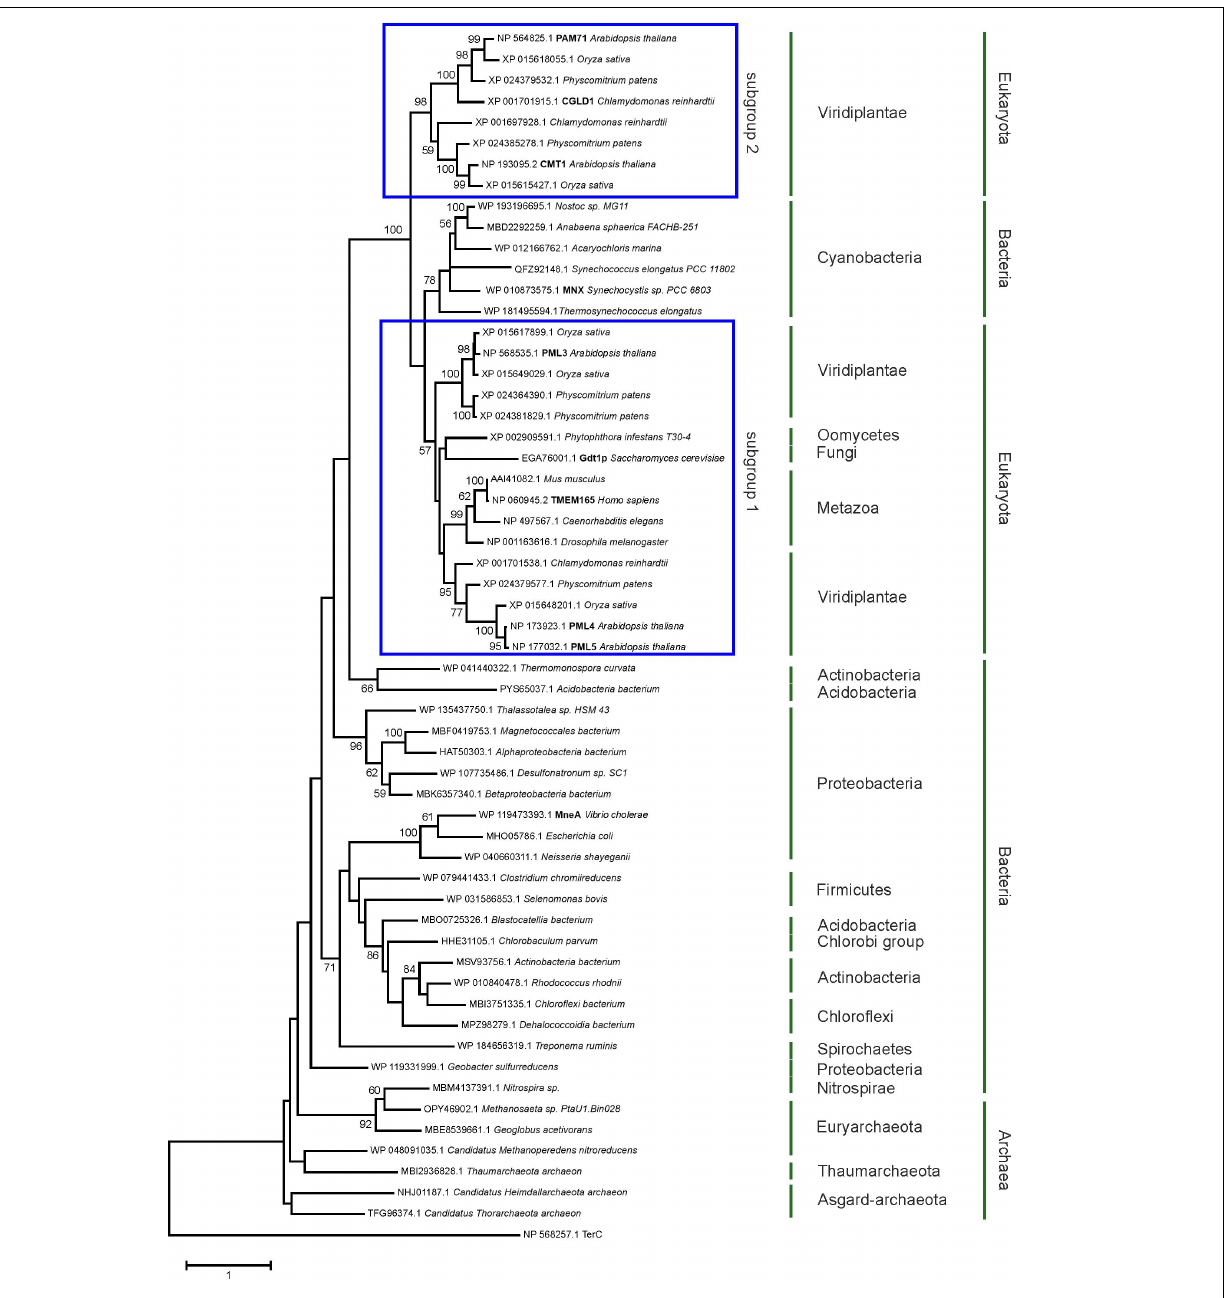
FIGURE 1 | Evolutionary analysis of UPF0016 members using the maximum-likelihood method. Protein sequences were retrieved by protein BLAST search using AtPAM71 as query sequence, except for those from Alphaproteobacterium bacterium , Vibrio cholera , Escherichia coli, Neisseria shayeganii , and Treponema ruminis , which were identified using MneA of Vibrio cholera as query sequence. The tree with the highest log likelihood is shown. The percentage ( > 50%) of trees in which the taxa grouped together is also shown (bootstrap values based on 500 replicates). The tree is drawn to scale with branch lengths measured in numbers of substitutions per site. The tree is rooted on Arabidopsis thaliana TerC. The TerC and UPF0016 families form part of the LysE transporter superfamily (http://pfam.xfam.org/clan/CL0292). NCBI accession numbers are indicated and proteins mentioned throughout the text are